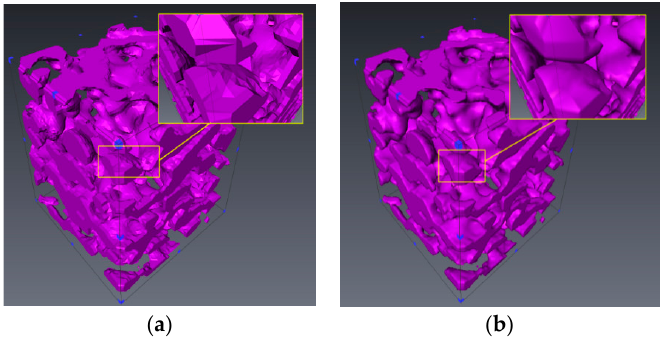
Figure 8. Model of micro-pore structure: ( a ) Before the optimization; and ( b ) after the optimization.